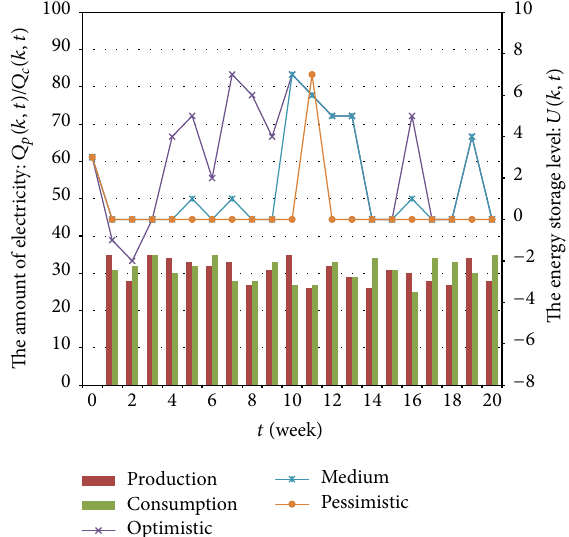
Figure 6: Trend of transaction price under different pricing strate- gies. Table 2: Total profit of each node by electricity